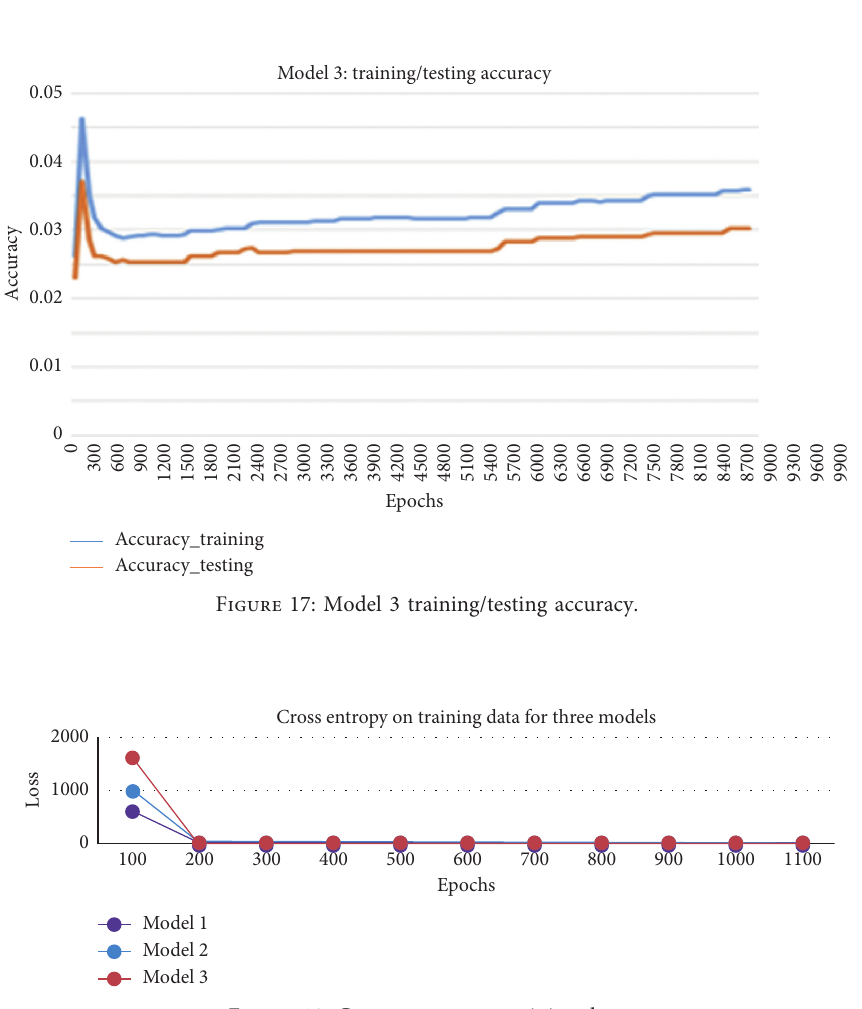
Figure 18: Cross-entropy on training